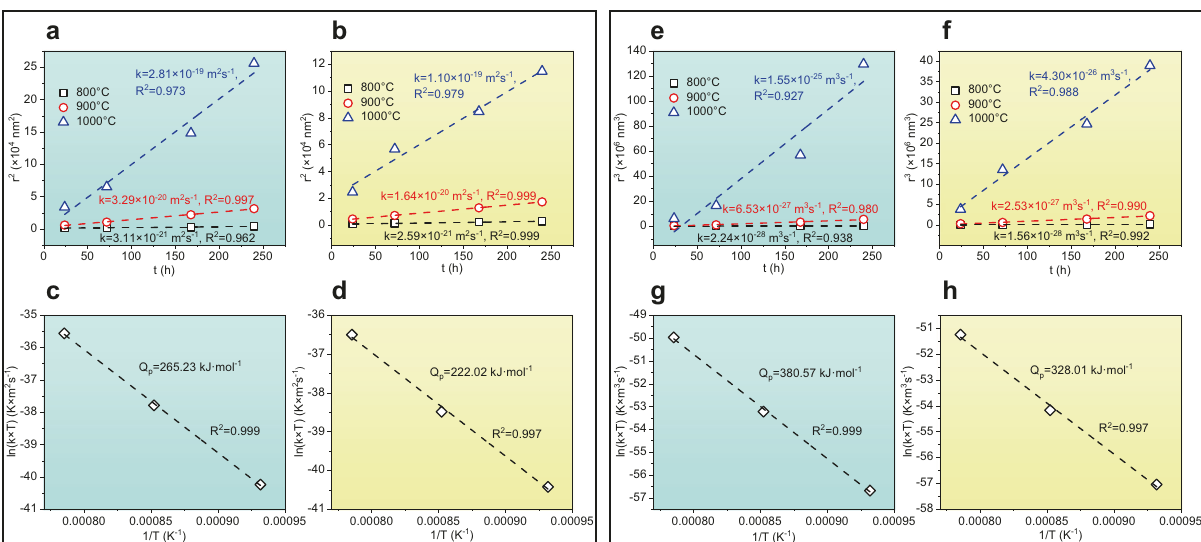
model. e , f Plotsof r 3 vs. t ofL1 2 precipitatesinthe0Coand15CoCCAsagedat800, 900,and1000°C. g , h Arrheniusplotofthecoarseningrateconstant(ln(k×T))asa function of the reciprocal aging temperature (1/T) gives the activation energy ( Q ) for the 0Co and 15Co CCAs based on the LSW model.